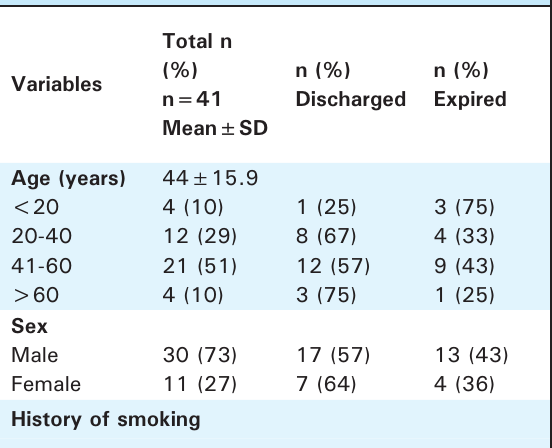
Table 1. Baseline characteristics of patients with lung abscess